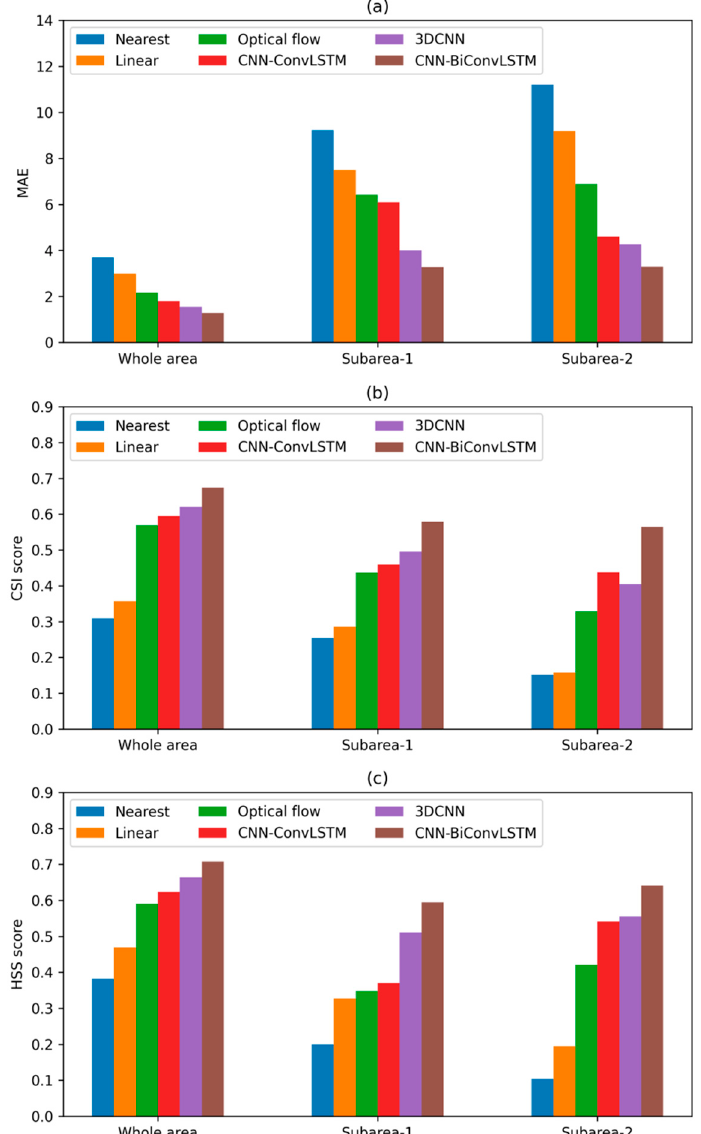
Figure 8. Evaluation results of MAE ( a ), CSI-30 scores ( b ), and HSS scores ( c ) for the example shown in Figure 7. Subarea-1 and subarea-2 correspond to the red box and black box in Figure 7, respectively.